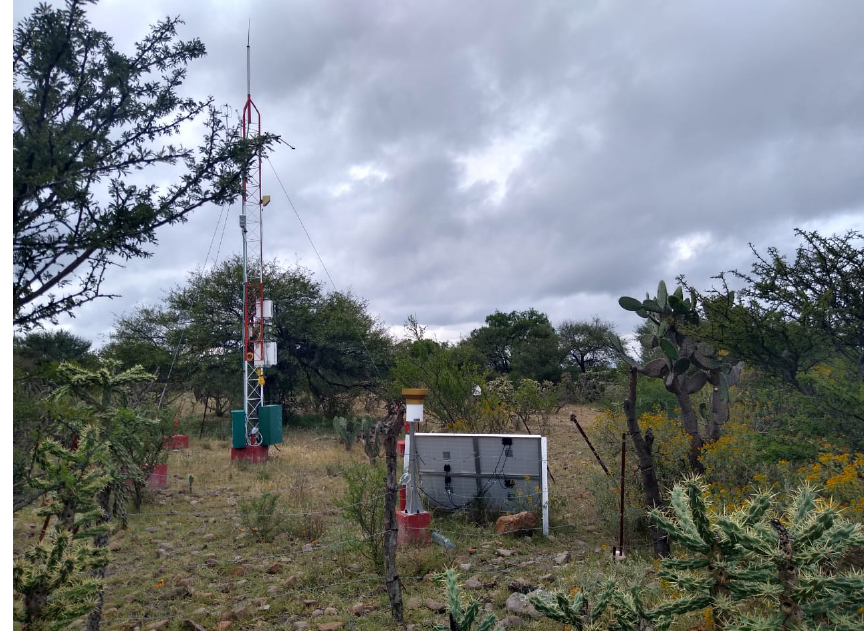
Figure 3. Thorny scrub at Bernal, Querétaro, during the rainy season 2017. In the foreground is Cylindropuntia imbricata , a very thorny cactus; shrubs in the background are Prosopis laevigata